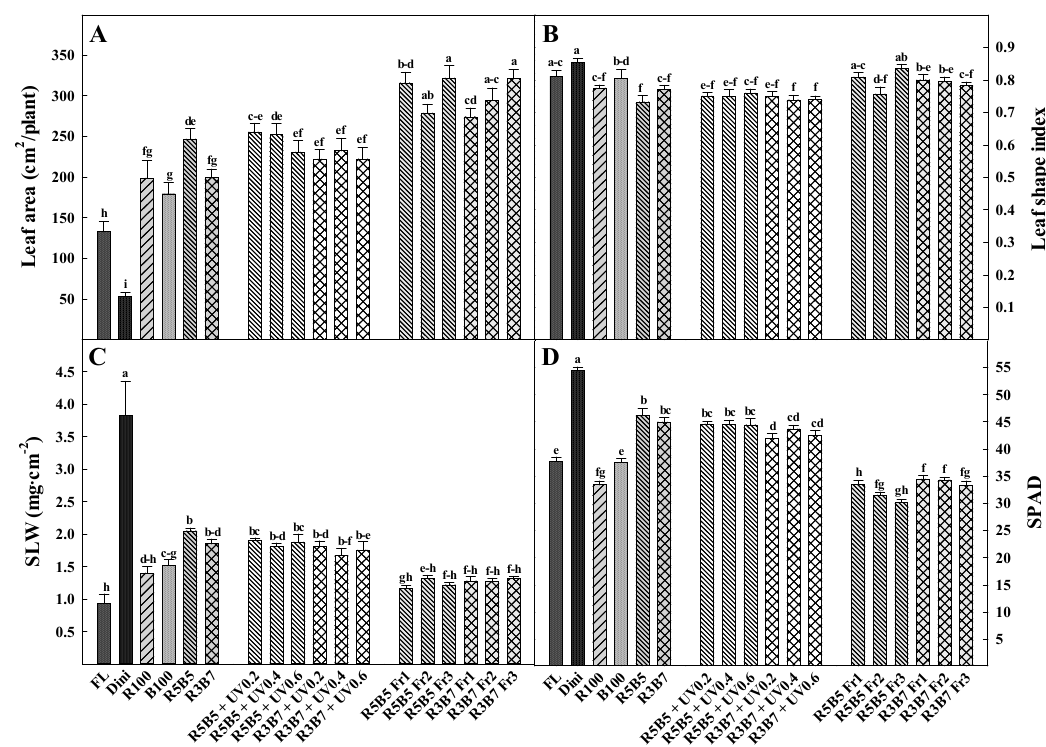
Figure 4. The effects of the light quality on ( A ) leaf area, ( B ) leaf shape index, ( C ) SLW, and ( D ) SPAD of “Joeunbaekdadagi” cucumber ( Cucumis sativus L.) plants measured at 22 days after treatment. Vertical bars indicate the mean ± SD ( n = 15). Different letters above the bars indicate significant differences by Duncan’s multiple range test at p ≤ 0.05.